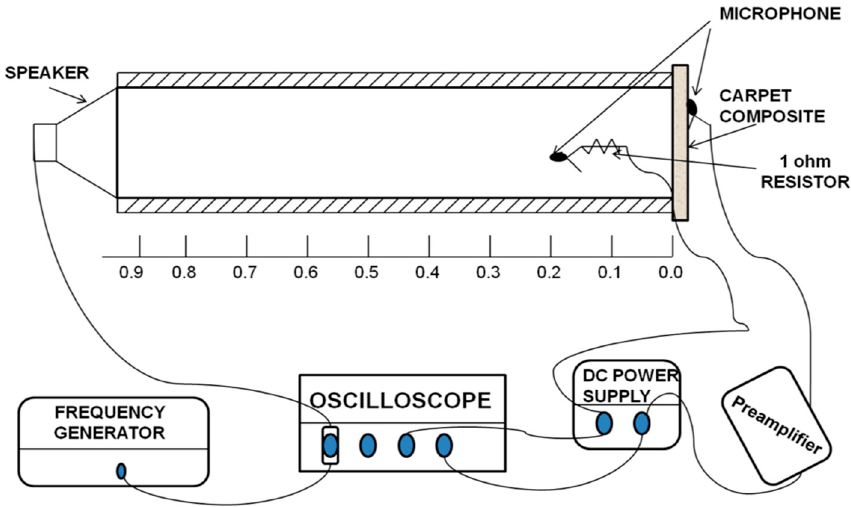
Figure 4. A schematic diagram to show the apparatus used for the acoustic test based on ASTM C–